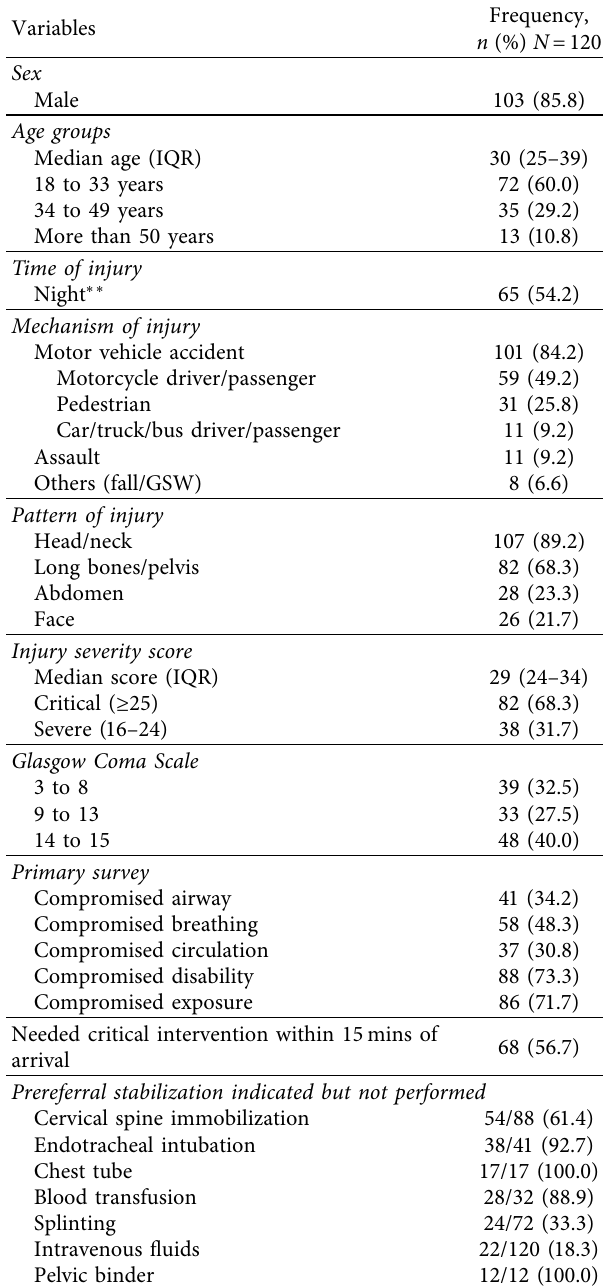
Table 1: Demographic and clinical characteristics of referral polytrauma patients who presented to the